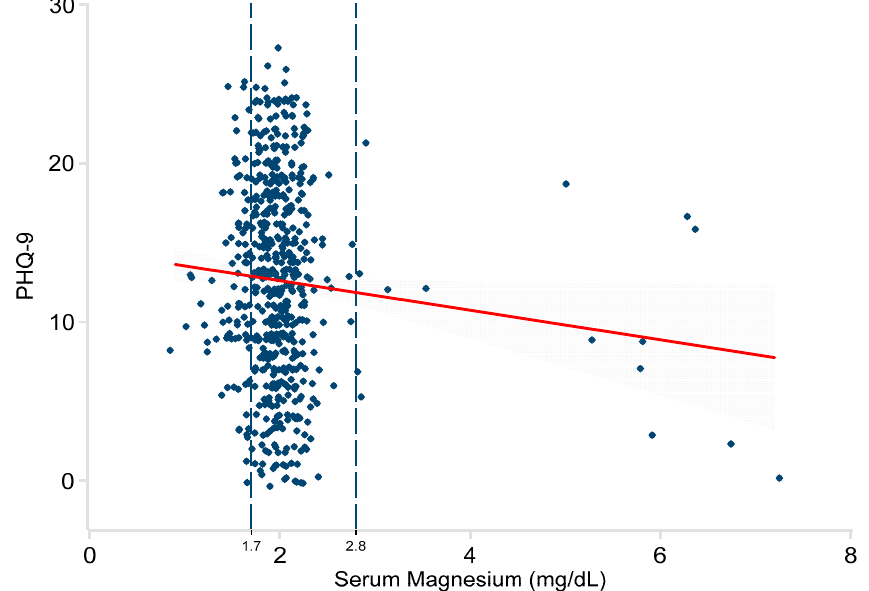
Figure 3. Relationship of serum magnesium to PHQ-9 scores in 616 adults. Patent Health Questionnaire-9 (PHQ-9). The red line represents the least-squares regression estimate. The grey area demonstrates the 95% confidence interval around that estimate. The vertical dashed lines represent the normal range of serum magnesium.